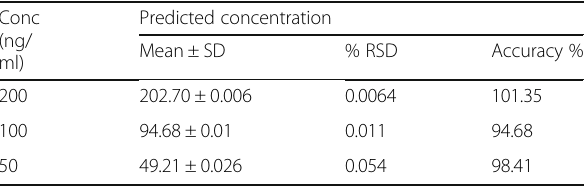
Table 2 Accuracy data for the developed bio-analytical method for naringenin in rat plasma Conc (ng/